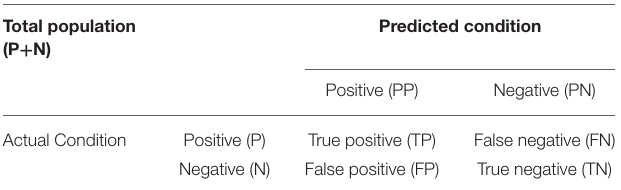
TABLE 1 | Hyper-parameters of the first task.